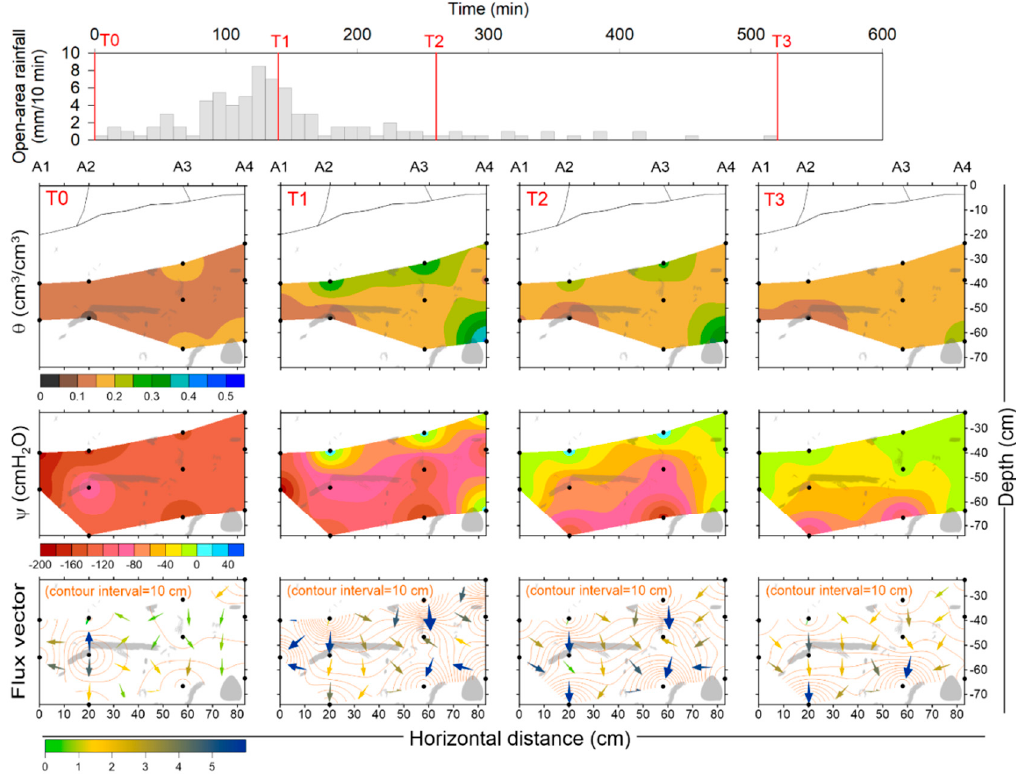
Figure 5. Spatial distributions of soil water content ( θ ), soil water potential ( ψ ), and flux vectors (from top to bottom rows) after 0 (T0), 140 (T1), 260 (T2), and 520 (T3) min (from left to right columns) during the second-largest rainfall event in the observation period. The size and direction of arrows indicate flux vectors (cmH 2 O/cm), which are plotted based on the spatial distribution of the hydraulic potential, which is shown with contour lines. Black circles and gray shapes on each plot indicate measurement points and roots exposed in the soil profile, respectively.